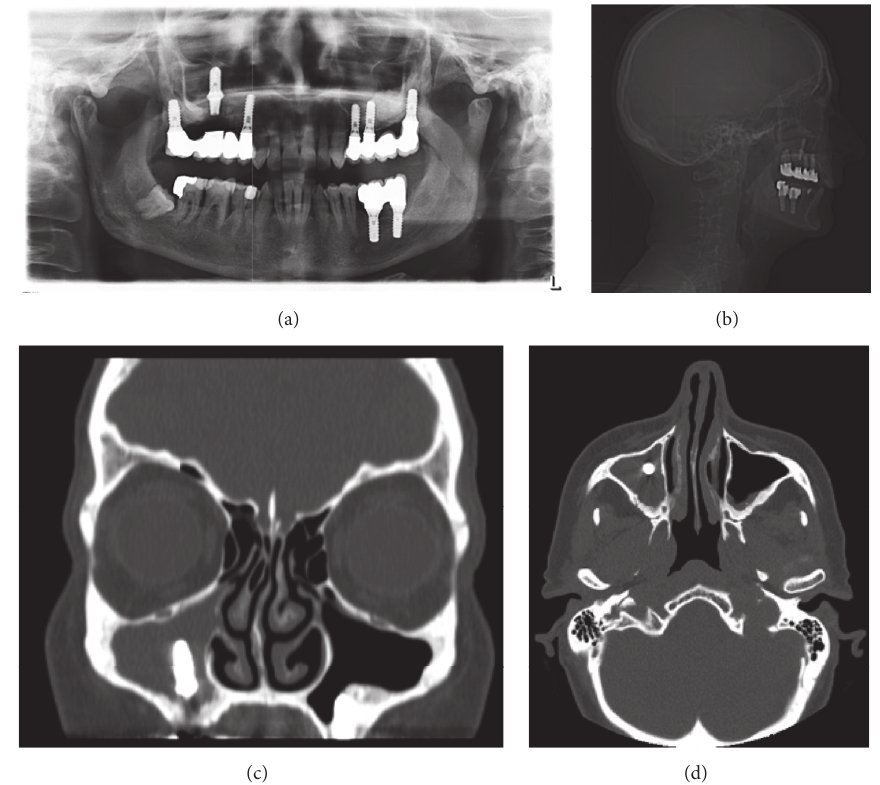
Figure 1: (a) Preoperative panoramic, (b) lateral cephalogram, and (c, d) CT scan radiographies showed the migration of dental implant sited in 1.6 positions into right maxillary sinus and clear signs of sinusitis.